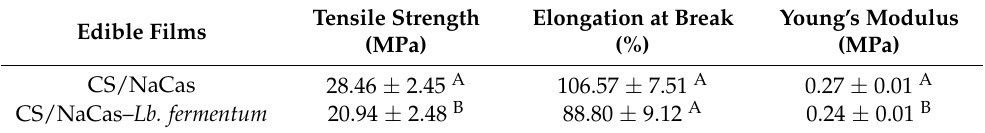
Table 6. Tensile strength, elongation at break, and Young’s modulus of composite edible films with or without Lb. fermentum . Tensile Strength Elongation at Break Young’s Modulus Edible Films (MPa) (%) (MPa) CS/NaCas 28.46 ± 2.45